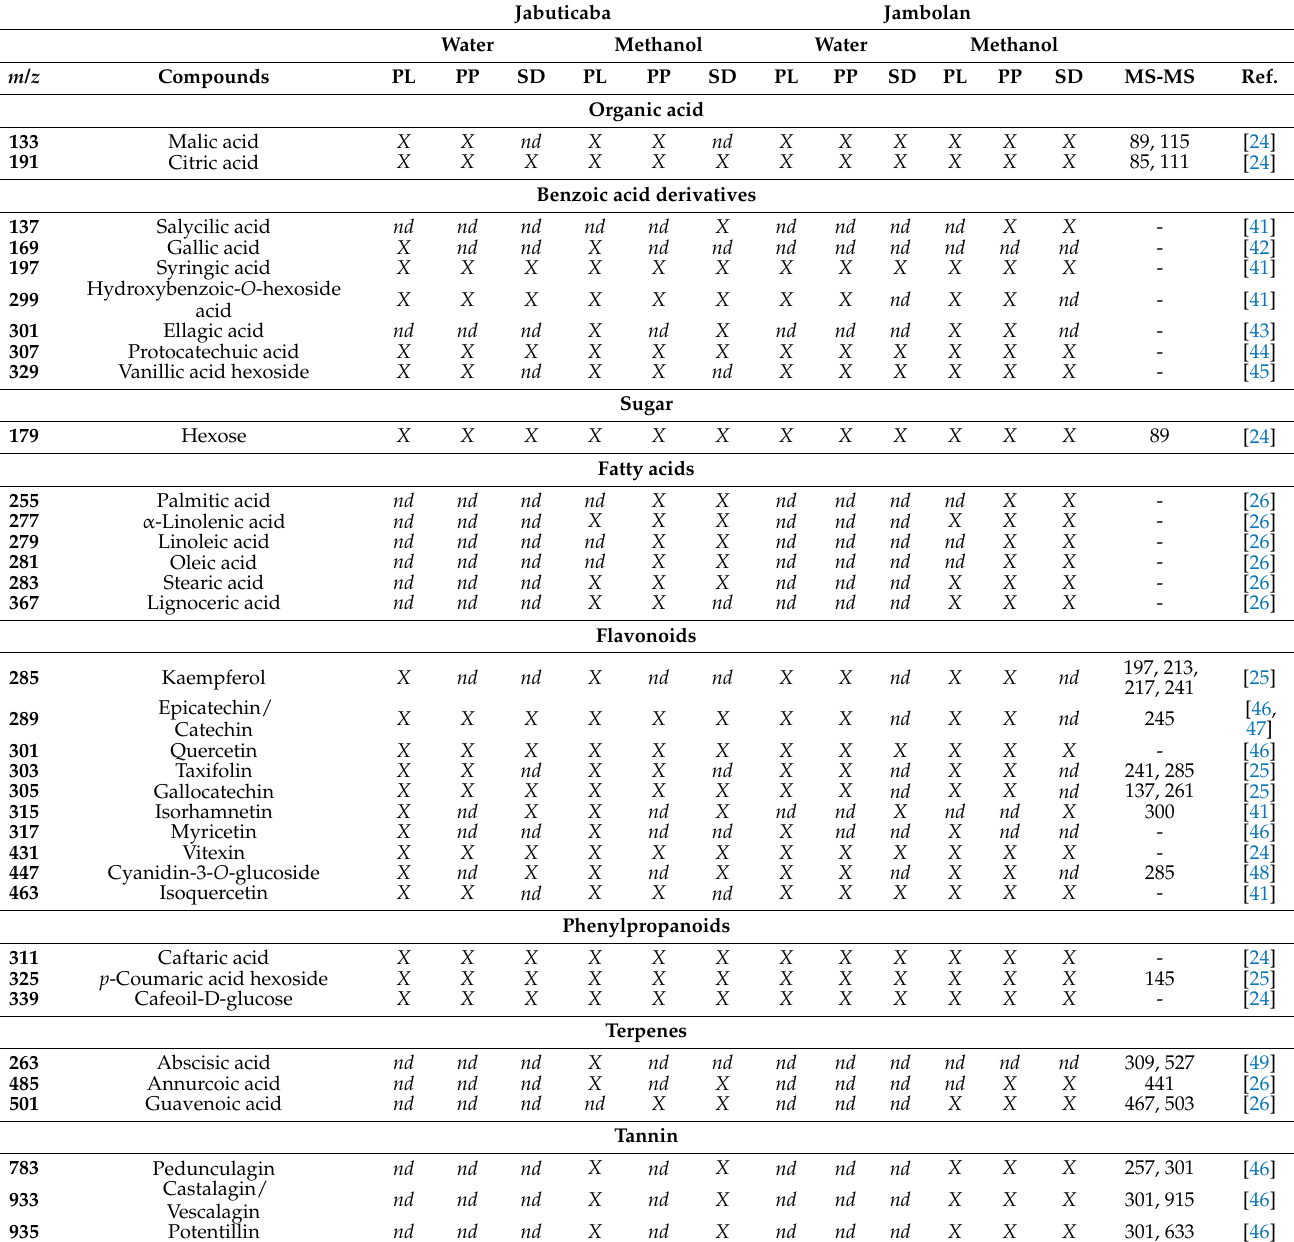
tagenic and DNA-protective properties for S. cumini seeds, and antioxidant, antimicrobial, anti-hyperglycemic, anti-inflammatory, and antihypertensive activities for jabuticaba seeds. The jabuticaba contains all 35 compounds tentatively identified in the negative ionization mode, whereas for jambolan, 33 compounds were found (gallic and abscisic acids were not detected; Table 3). In the negative mode, some flavonoids also show an isomeric relationship and evidently could not be differentiated by their exact mass; examples are provided by epicatechin and catechin ( m / z 289), as well as some tannins, such as castalagin and vescalagin ( m / z 933). Table 3. Compounds provisionally identified in the peel (PL), pulp (PP) and seeds (SD) of jabuticaba and jambolan fruits by (-)